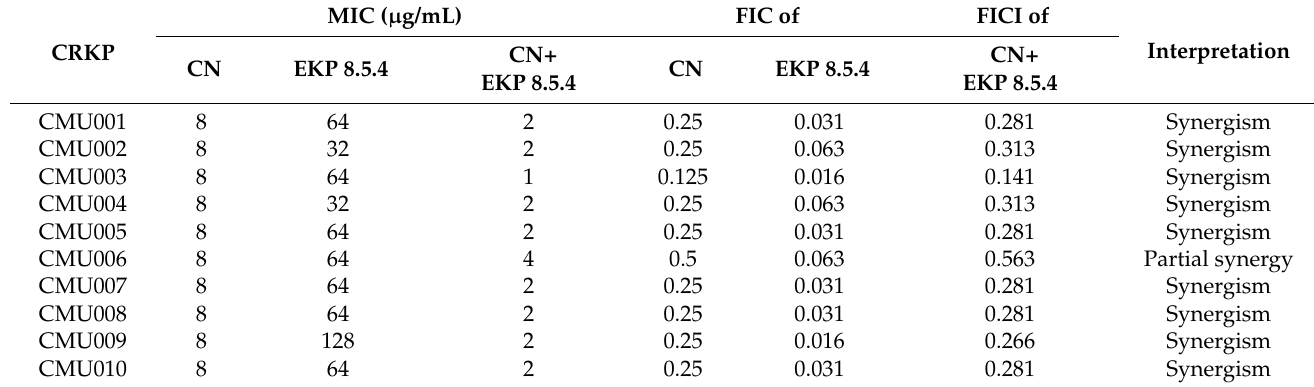
Table 3. Combination effect of gentamicin and EKP 8.5.4 extract against CRKP.